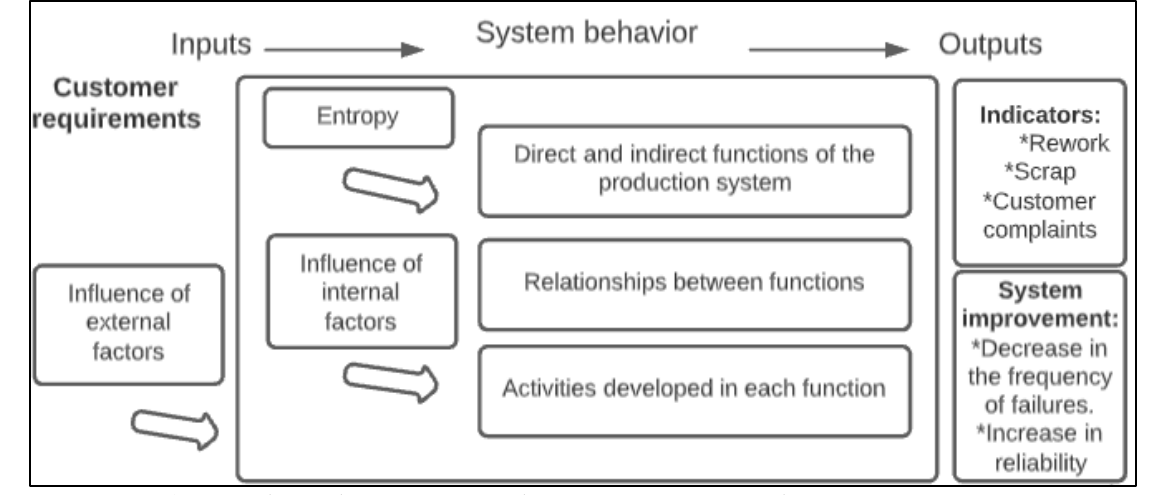
Figure 2. The production system with an open system approach.